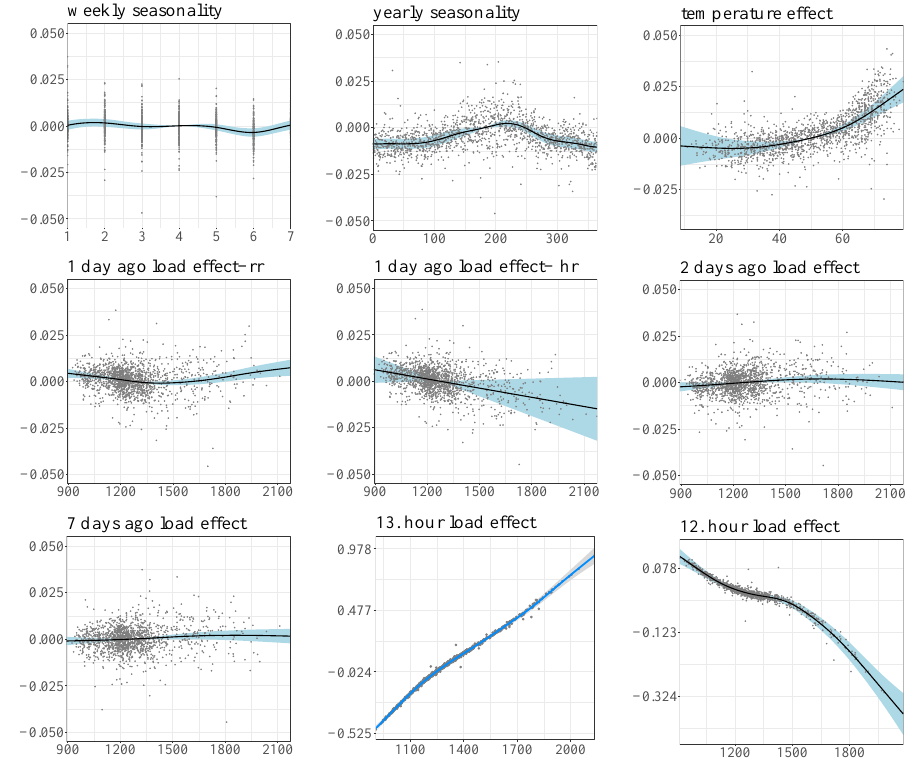
Figure 7. Partial residual for the 14th hour for GENESE